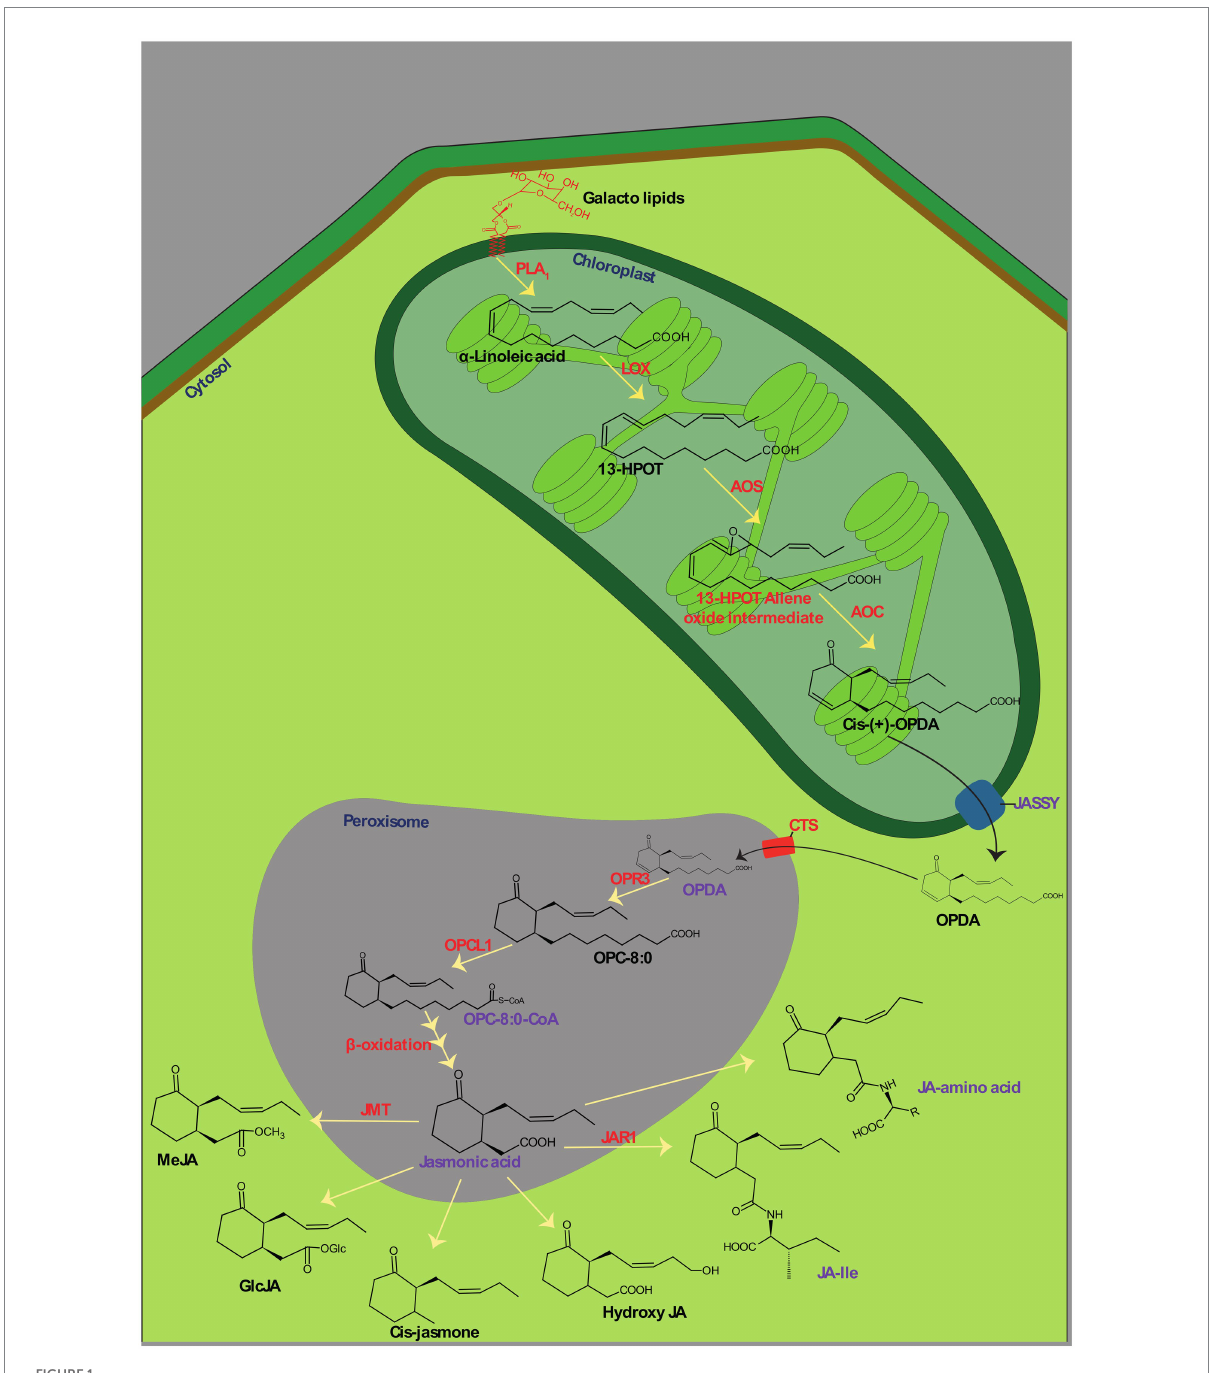
FIGURE 1 Biosynthesis of jasmonic acid (JA) and its direct derivatives. PLA 1 , Phospholipase A1; LOX, 13-lipoxygenase; HPOT, 13S-hydroperoxyoctadecatrienoic acid; AOS, Allene oxide synthase; AOC, Allene oxide cyclase; OPDA, Oxophytodienoic acid; OPR3, OPDA reductase; OPC-8:0, 3-oxo-2(29-[Z]-pentenyl)cyclopentane-1-octanoic acid; OPCL1, OPC-8:0 CoA ligase 1; JMT, Jasmonic acid carboxyl methyltransferase; JAR1, Jasmonate resistance-1; MeJA, Methyl jasmonate; GlcJA, Jasmonic acid Glycosyl ester; JA-Ile,